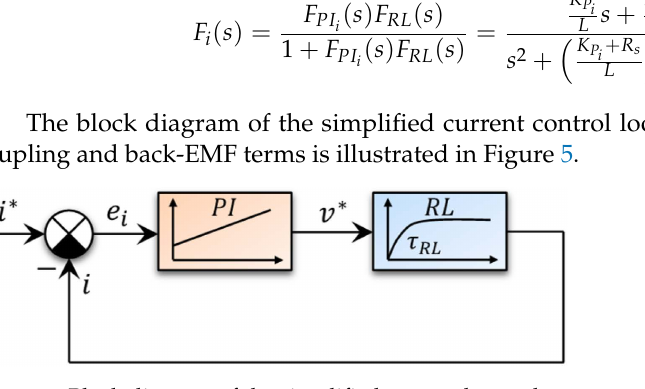
Figure 5. Block diagram of the simplified current loop scheme.